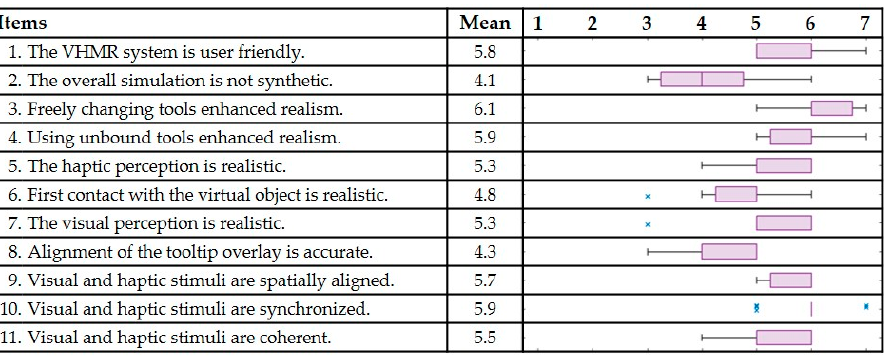
Figure 14. User evaluation questionnaire and